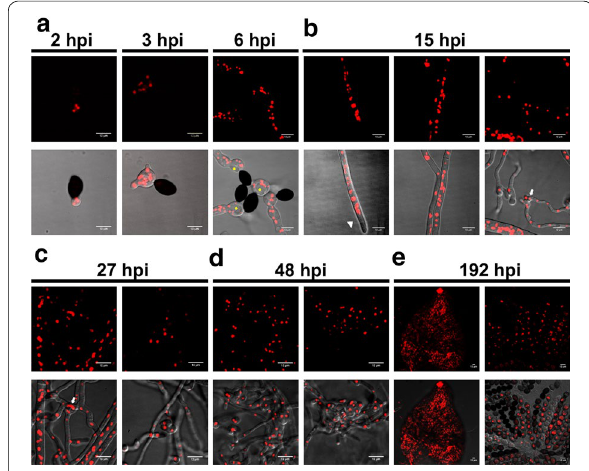
Fig. 2 Live‑cell imaging of nuclear distribution during the S. fimicola life cycle. The H2B‑mCherry‑labeled strain was cultured on malt extract agar III under constant white light. The nuclear distribution in a single germination vesicle and germ tube from an ascospore was observed at 2, 3, and 6 h post‑inoculation (hpi). At 15 hpi, nuclear fluorescence was distributed in the mature vegetative hyphae and hyphal fusion regions, whereas the nuclei were not detected in the hyphal tip regions of the mature vegetative hyphae. Nuclear distribution in the coil and ascogonia hyphae, including the early protoperithecia, was detected within 27 and 48 hpi, respectively. At approximately 192 hpi, mature perithecia with asci containing black mature and multinucleated ascospores were observed. Live images were captured with the Deltavision core system. Nuclear distribution in each developmental stages of S. fimicola including germination vesical formation ( a ), hyphal extension and contact ( b ), ascogonial coils formation ( c ), differentiated ascogenous hyphae development (protoperithecia) ( d ) and perithecia formation ( e ) are showed. White arrows and arrowheads indicate hyphal fusion and the extension tip of a vegetative hypha, respectively. Yellow asterisks indicate vacuoles.